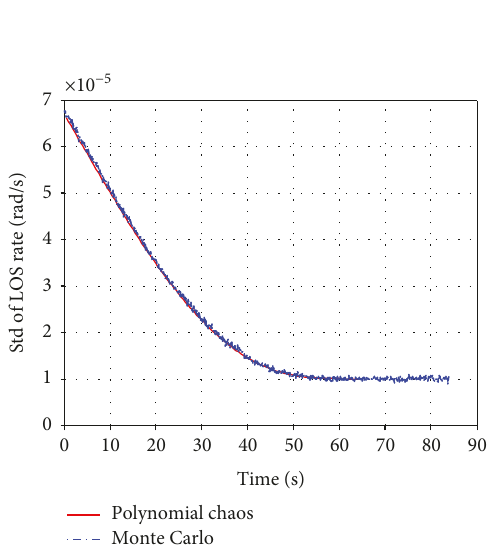
Figure 14: Mean of the LOS